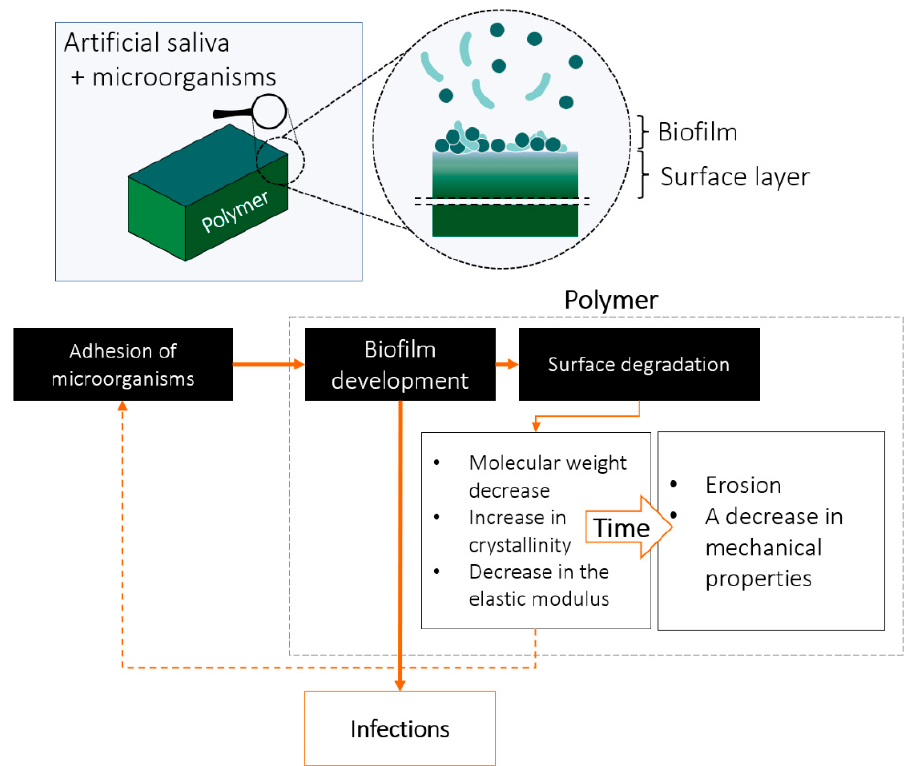
Figure 7. Diagram of the processes taking place at the polymer–biofilm interface in the oral cavity environment on the example of the conducted studies.